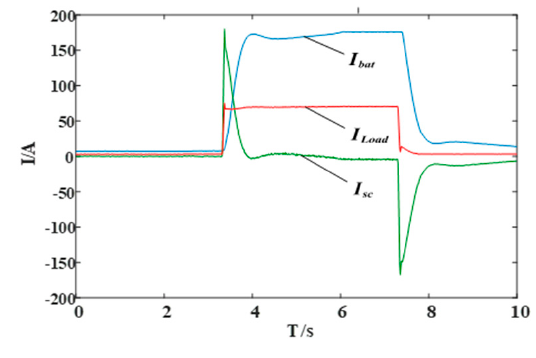
Figure 13. Experimental platform of DEPA.